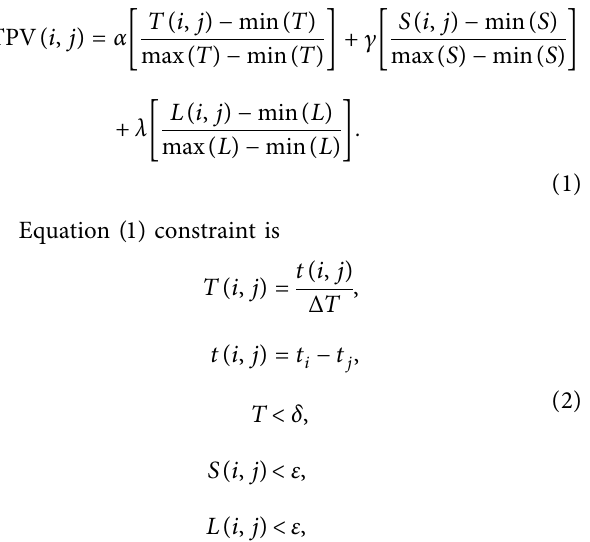
Algorithm 1 for calculating the time-space